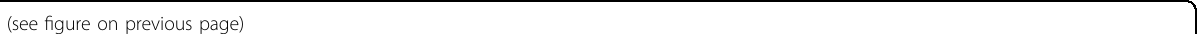
Fig. 7 Comparison of DL-OCT blind testing results using 3× undersampled, 2× undersampled, and A-line-optimized input spectral data. Three mouse embryo samples (never seen by either of these DL-OCT networks) are imaged for blind testing. PSNR and SSIM values are also displayed for each one of these fi elds-of-view. Ground truth images used 1280 spectral data points per A-line, whereas 2× and 3× DL-OCT networks used N spec = 640 and N = 427 spectral data points per A-line, respectively. The A-line-optimized network used N spec also see Supplementary Fig. S5.